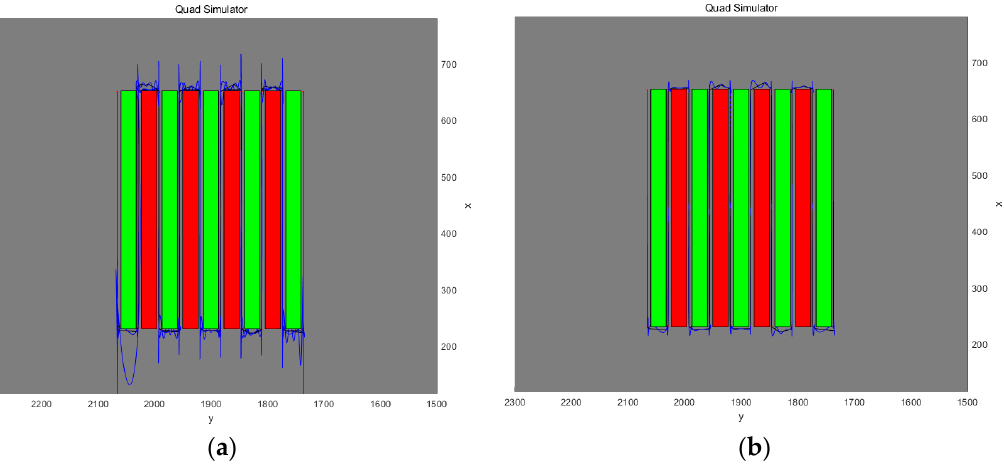
Figure 11. Trajectory optimization comparison in local environment. ( a ) Trajectory generated by the previous based on bias_RRT* algorithm. ( b ) Trajectory generated by the proposed method based on improved bias_RRT* algorithm.